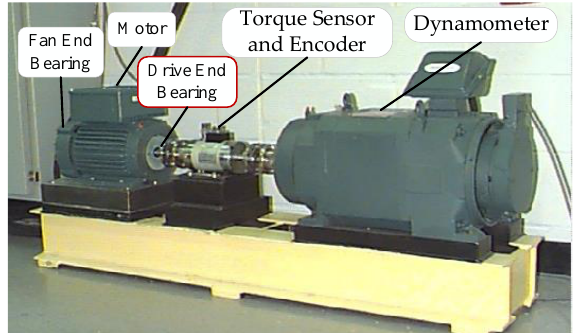
Figure 5. The bearing data acquisition device. From left to right are fan end bearing, motor, drive end bearing, torque sensor and encoder, and dynamometer. The place marked in the red box is the drive end bearing we need to